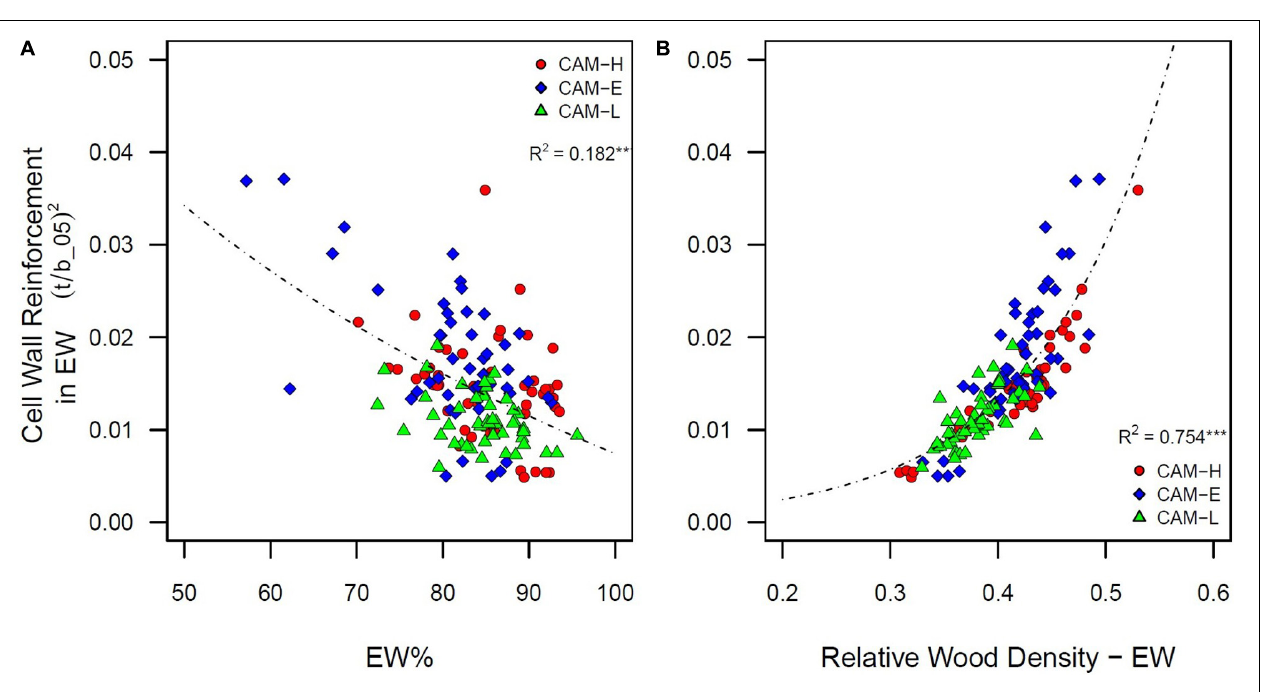
Frontiers in Plant Science |